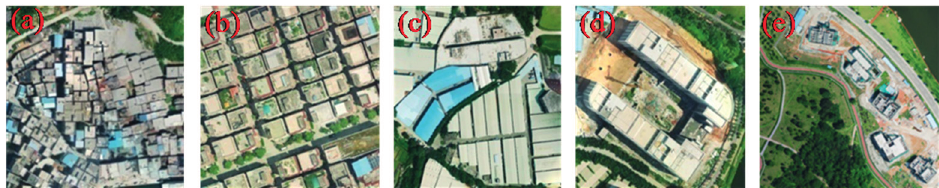
Figure 4. Five details of Figure 3b representing the five different types of buildings in the experimental data set: ( a ) residential area with scattered dense buildings, ( b ) residential area with buildings densely aligned along the street, ( c ) industrial area with dense large buildings, ( d ) high-rise buildings, and ( e ) suburban area with detached